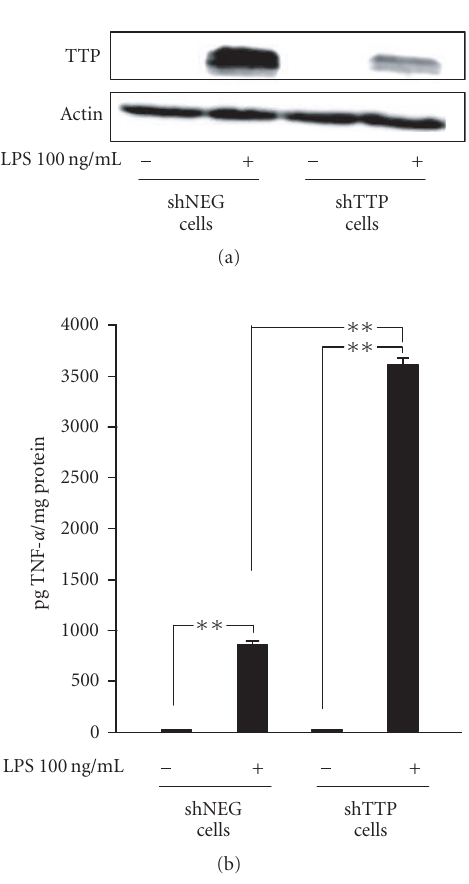
Figure 1: Down-regulation of TTP expression and enhancement of TNF- α production in shTTP cells. (a) shNEG and shTTP cells were stimulated with LPS (100ng/mL) and proteins were extracted af- ter 6h of incubation. TTP and actin were detected by Western blot. The blot is a representative of three blots with similar results. (b) shNEG and shTTP cells were stimulated with LPS (100ng/mL) for 1h. Thereafter the medium was changed and the cells were incu- bated for another 48h. TNF- α concentrations in the culture me- SEM ( n = 3). dia were measured by ELISA. Values are mean (cid:0) = P < . 01. (cid:2)(cid:2)